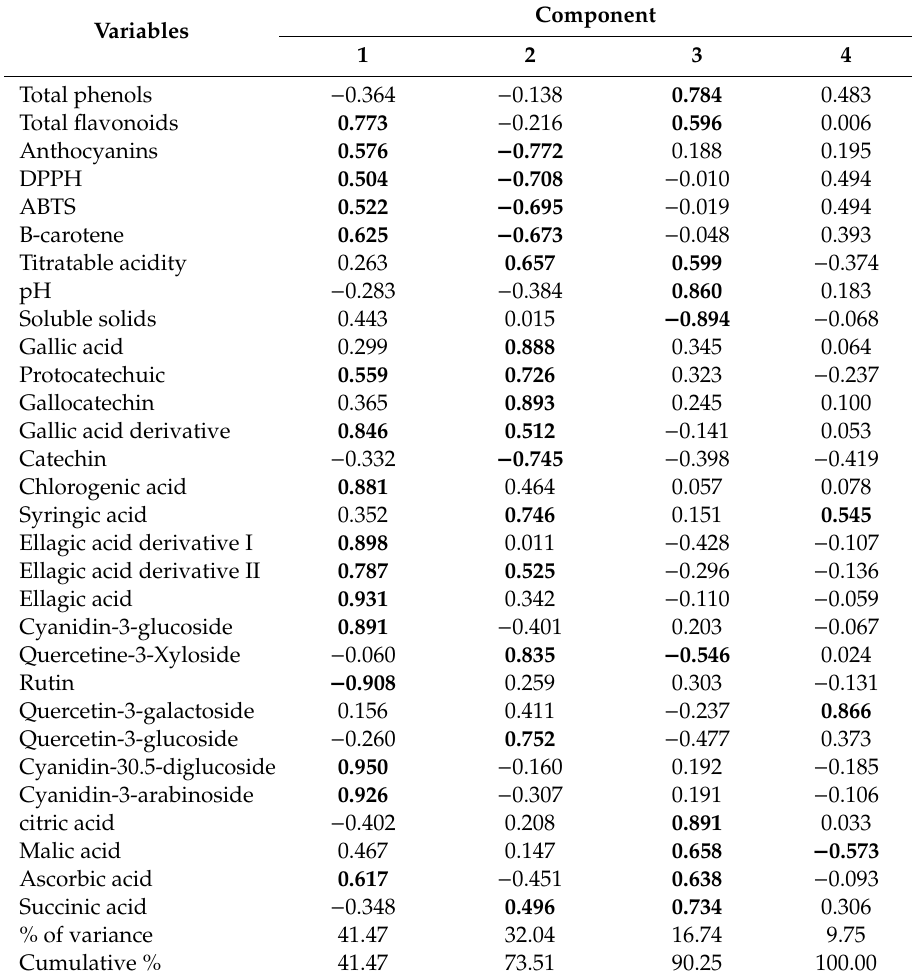
Table 11. Eigenvectors of principal component axes from principal component analysis (PCA) analysis of studied